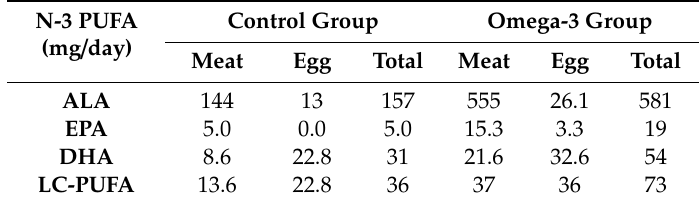
Table 2. Average daily intake of n-3 PUFA in mg / day from chicken meat and eggs during the intervention above the baseline